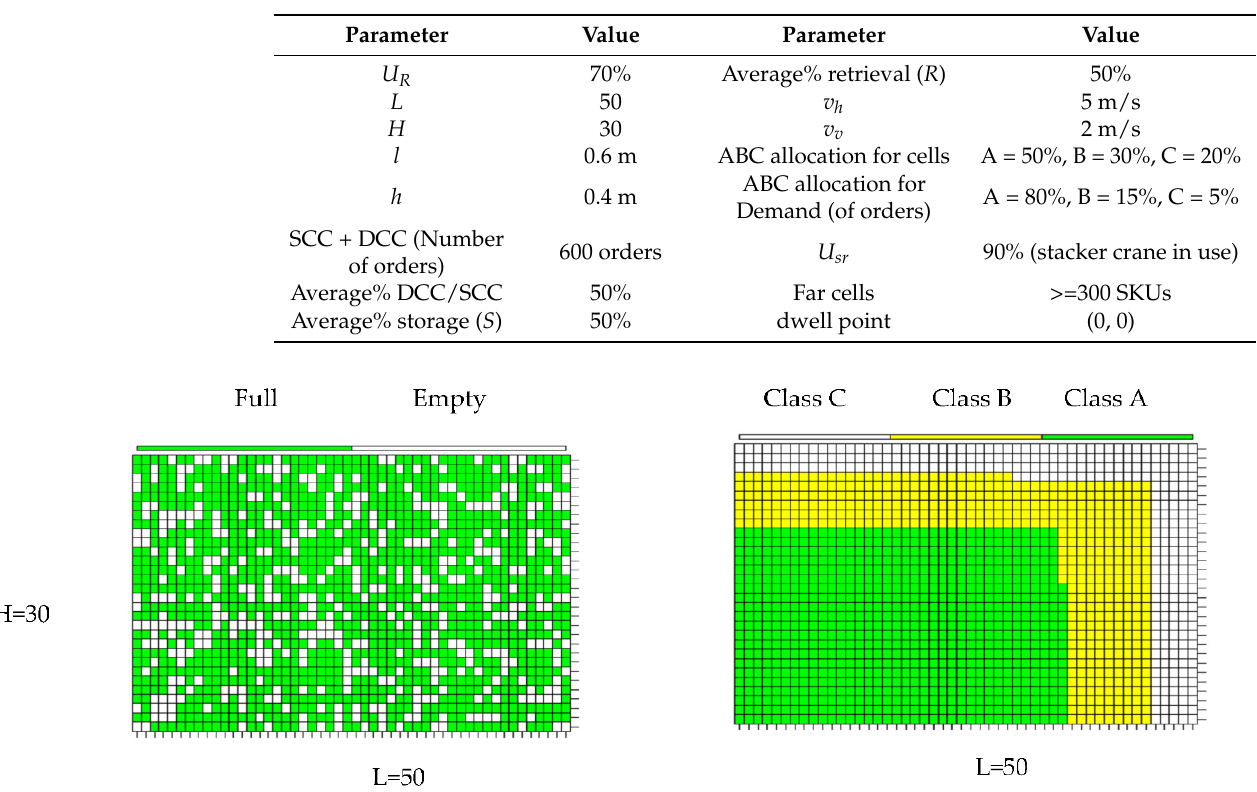
Figure 4. Initial loads allocation and ABC cells’